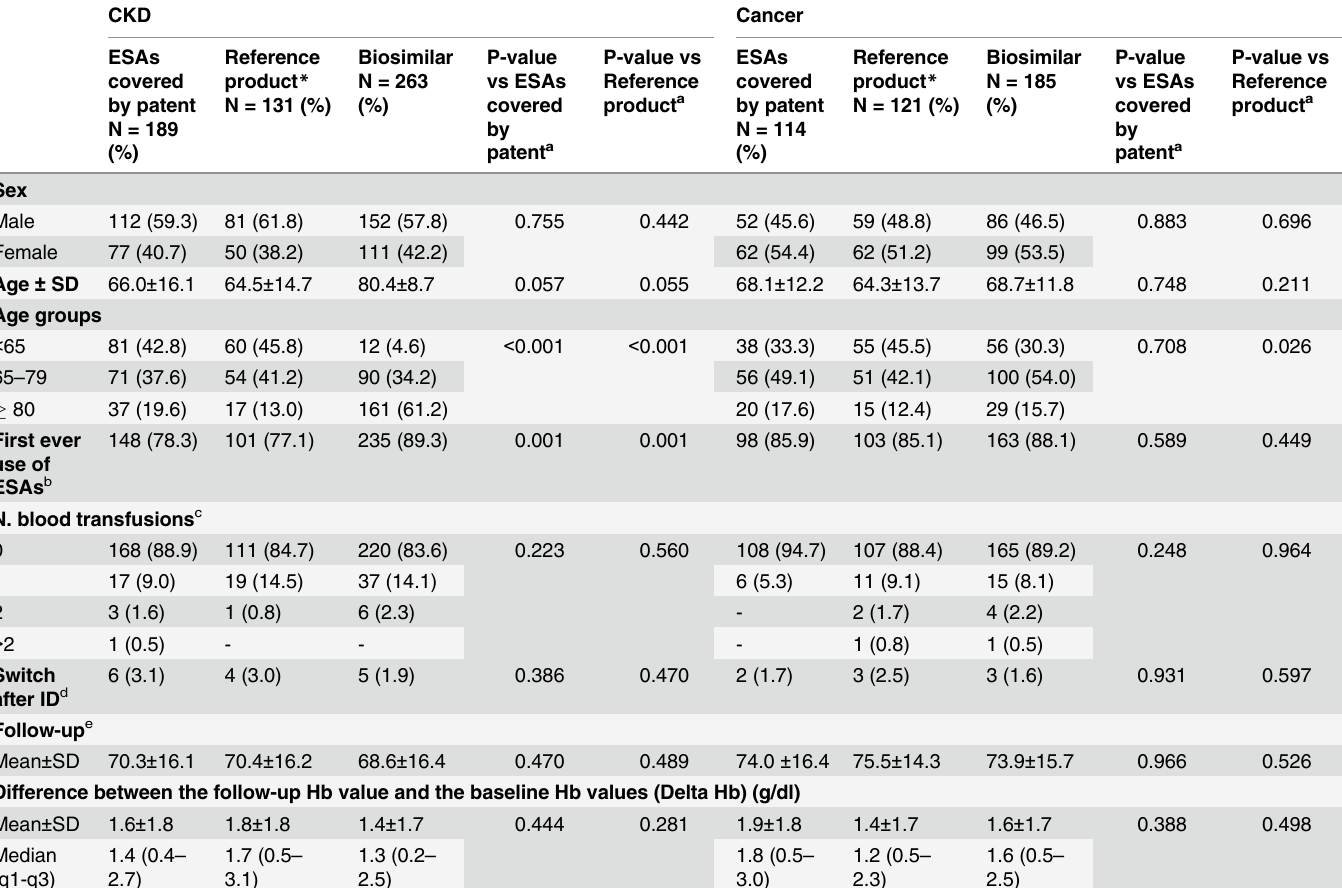
Table 1. Demographic characteristics of incident ESA users, stratified by indication for use and type of